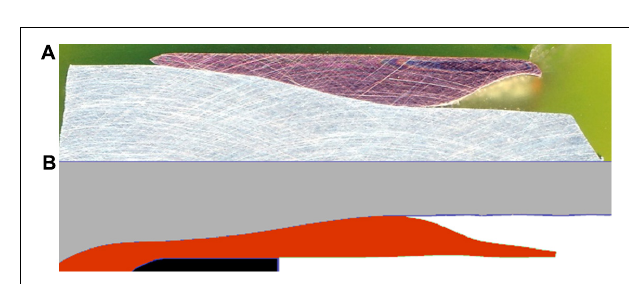
FIGURE 13 | Overlay of an experimental (A) and simulated (B) sleeve separation; extrusion direction →